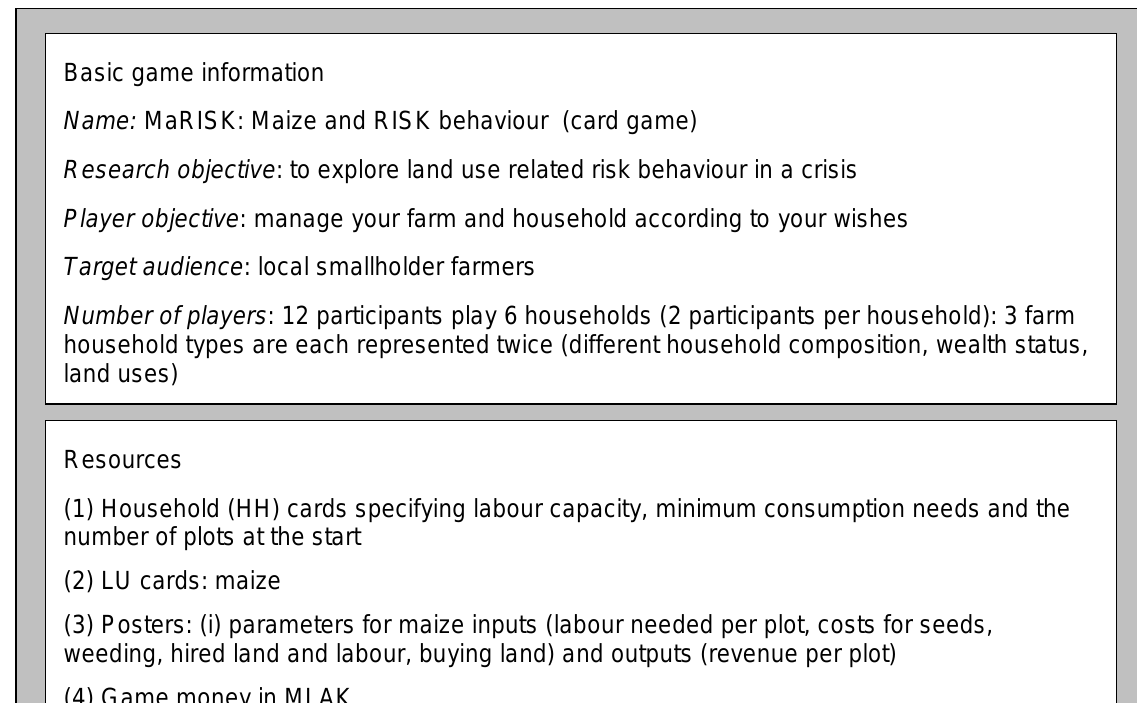
Figure A.2.3. Description MaRISK Card Game developed in Namen